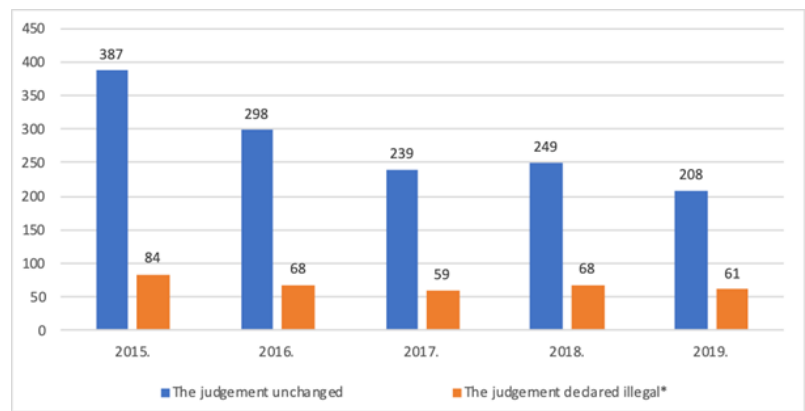
Figure 4: Rulings adopted by the Supreme Court of the Republic of Lithuania in accordance with Chapter XXXIV of the Code of Criminal Procedure [Designed by the author based on data retrieved from: The Supreme Court of Lithuania, 2020., No. (1.15)5F-2 35 ] * “ The judgement declared illegal ” - the Supreme Court, upon hearing the criminal case in accordance with Chapter XXXIV of the Code of Criminal Procedure, annulled the decision in full or in part, amended the decision or terminated the